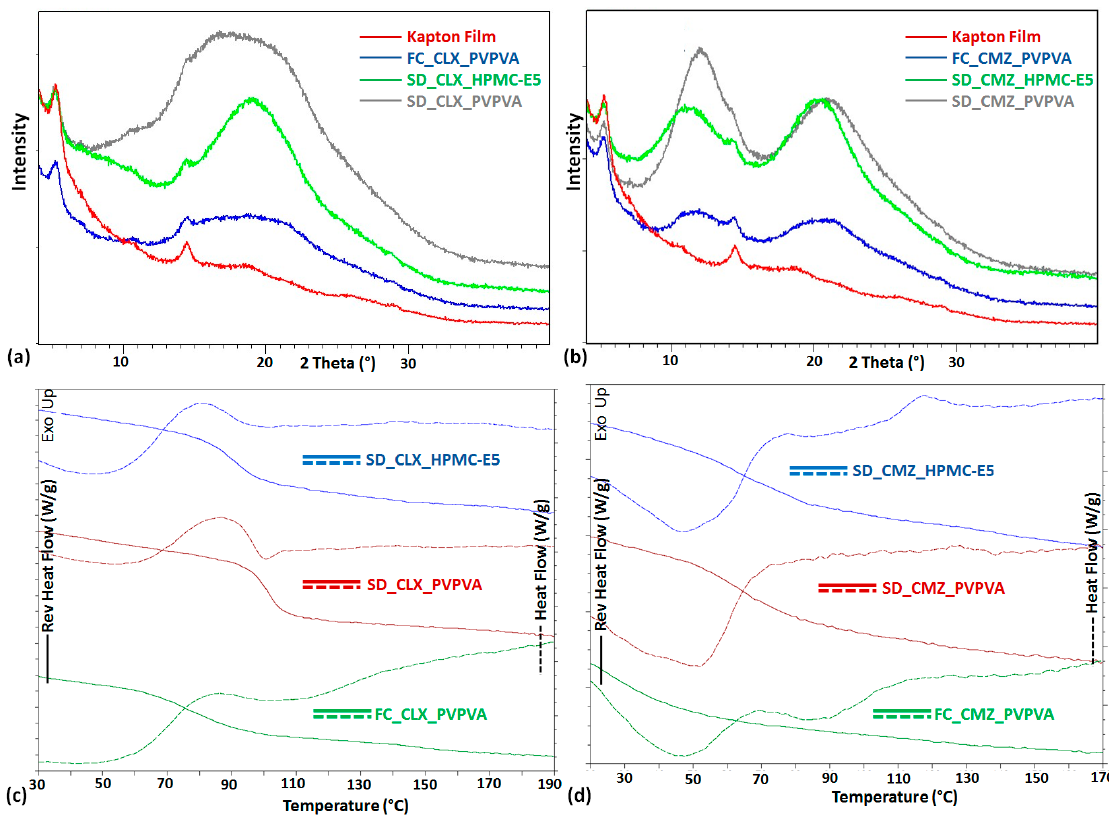
Figure 1. Powder X-Ray diffraction (PXRD) diffractogram of amorphous solid dispersions (ASD) sample, prepared by film casting and spray drying methods, with ( a ) Celecoxib and ( b ) Clotrimazole. ( c )–( d ) Their corresponding modulated differential scanning calorimetry (DSC) thermograms, showing reversing heat flow (as a solid line) and heat flow (as broken line) signals.